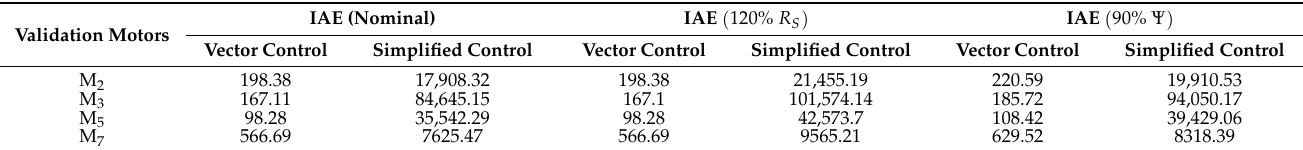
Table 3. Integral absolute error (IAE) comparison under varying motor